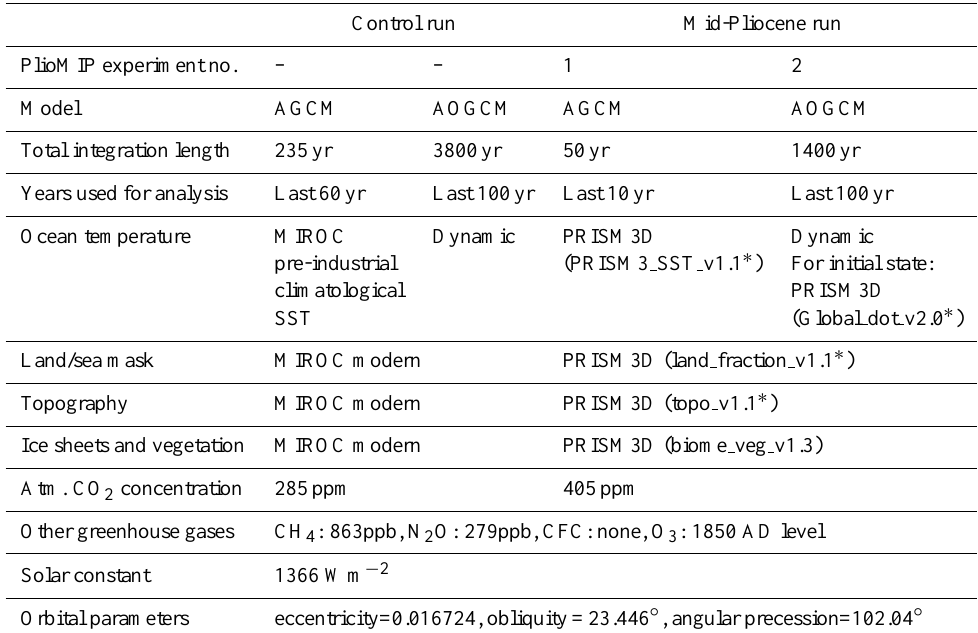
Table 1. Summary of the experimental design, parameters and boundary conditions imposed. The names of PRISM3D data files used are enclosed in brackets. Those applied as an anomaly to control experiment data sets are marked with an asterisk.